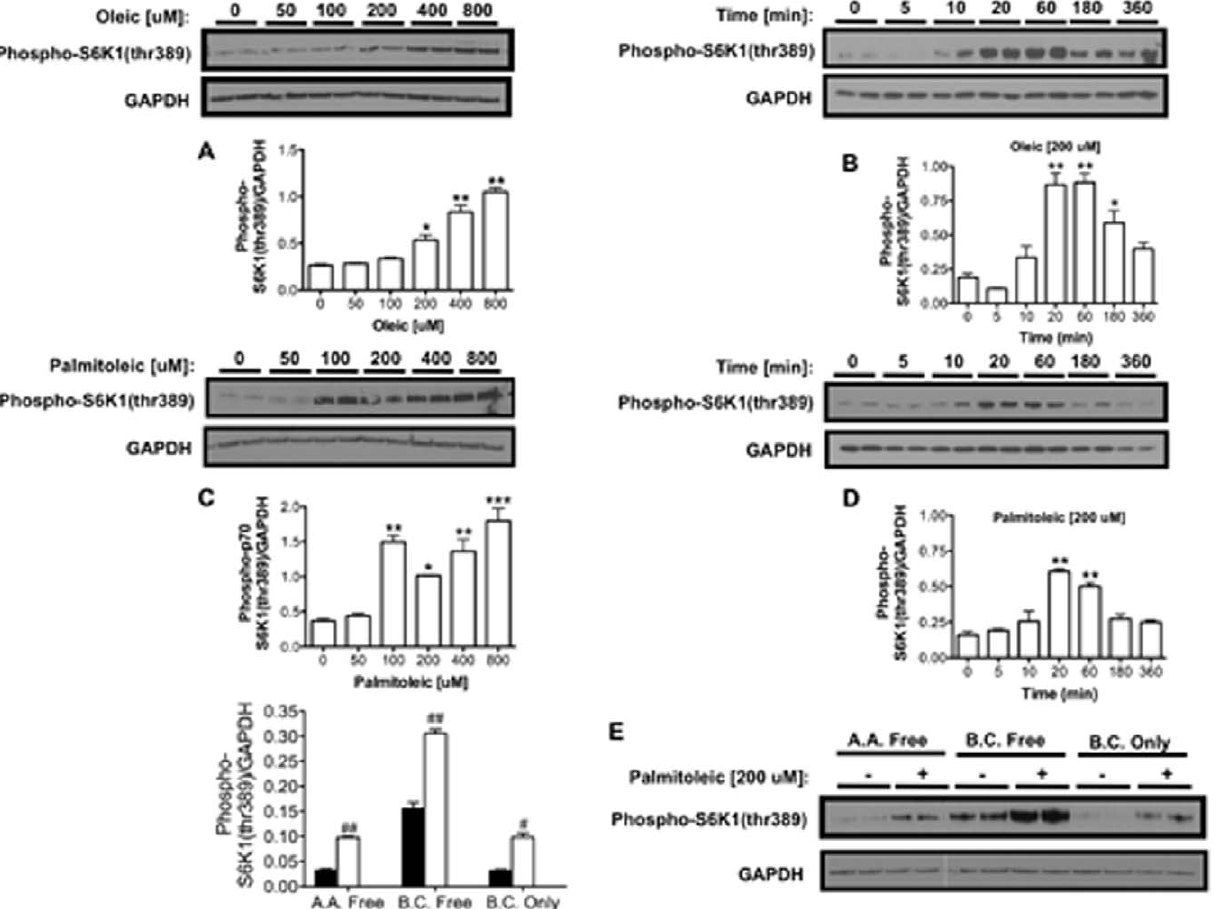
Figure 1. Fatty acids activate S6K1 in vitro in the muscle cell line Sol 8. Oleic acid increased S6K1 phosphorylation in Sol 8 cells in a dose- dependent (A) and time-dependent (B) manner. Similar results were obtained with palmitoleic acid (C and D). S6K1 phosphorylation induced by palmitoleic acid was independent of branched-chain amino acids and amino acids in general (E). A.A., amino acid; B.C., branched-chain amino acid. One way ANOVA * P , 0.05, ** P , 0.01, *** P , 0.001; two-tailed t test # P , 0.05, ## P , 0.01.